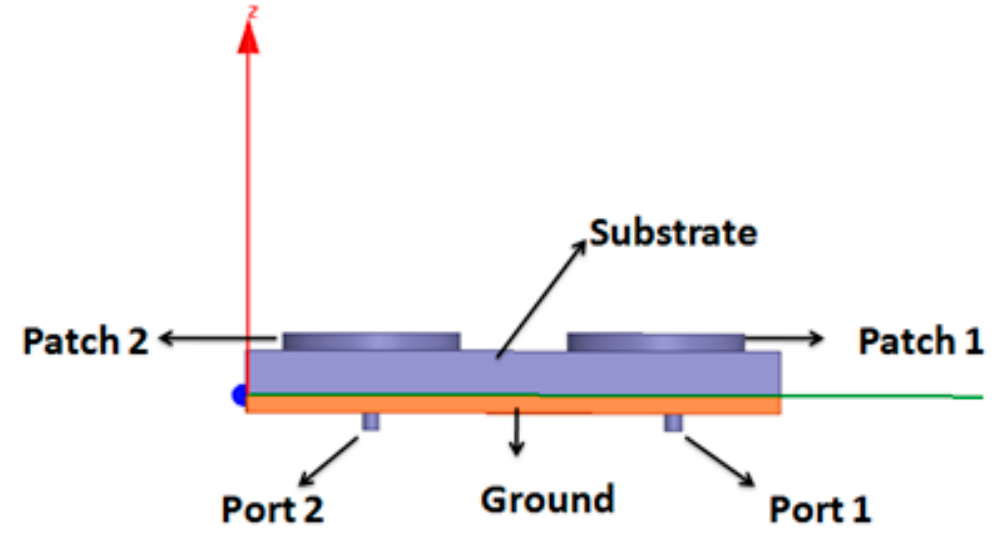
Figure 1. The proposed MIMO antenna.